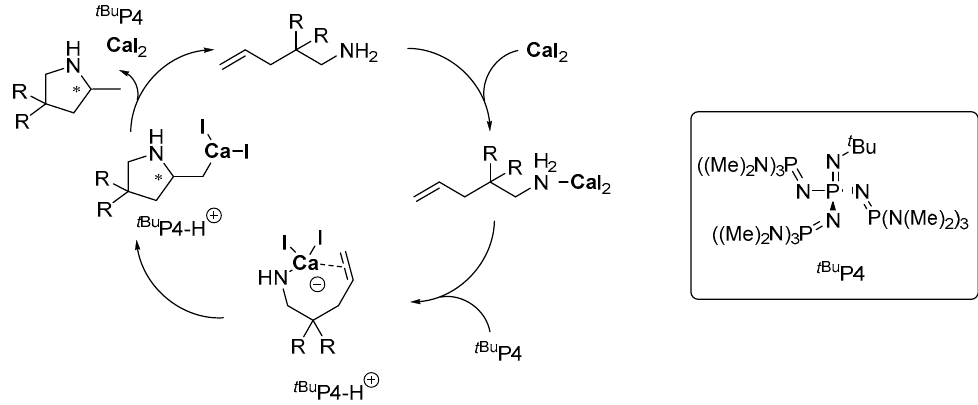
troscopy. c Enantiomeric excess (= ee ) determined by 1 H and/or 19 F NMR spectroscopy after deri- vatization with Mosher’s acid. The absolute configuration was not determined for the reaction products.